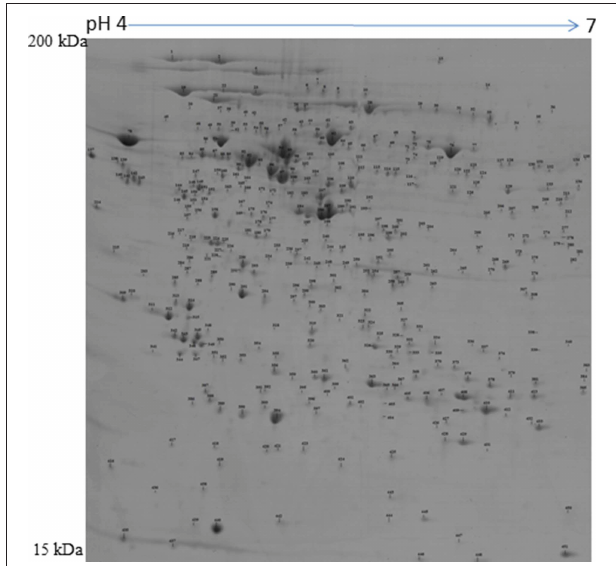
FIGURE 1 | Representative protein map of the porcine preovulatory follicles. Proteins corresponding to spot numbers are listed in Supplementary Table 1